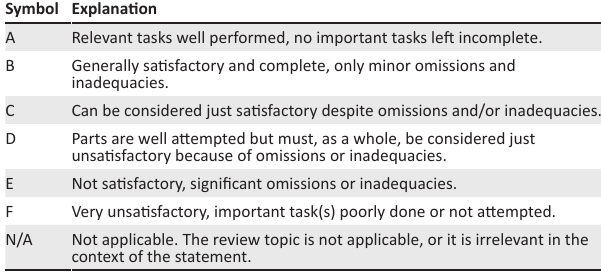
FIGURE 2: Hierarchical structure of the Lee and Colley Environmental Impact Assessment report review package. TABLE 2: List of assessment